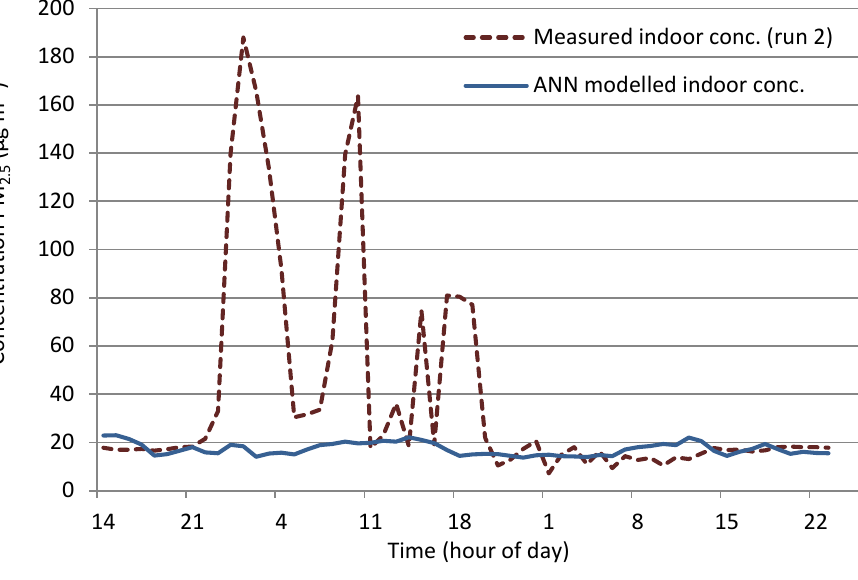
Figure 10. Measured versus modelled indoor PM 2.5 concentrations at M c 3 (run 2).